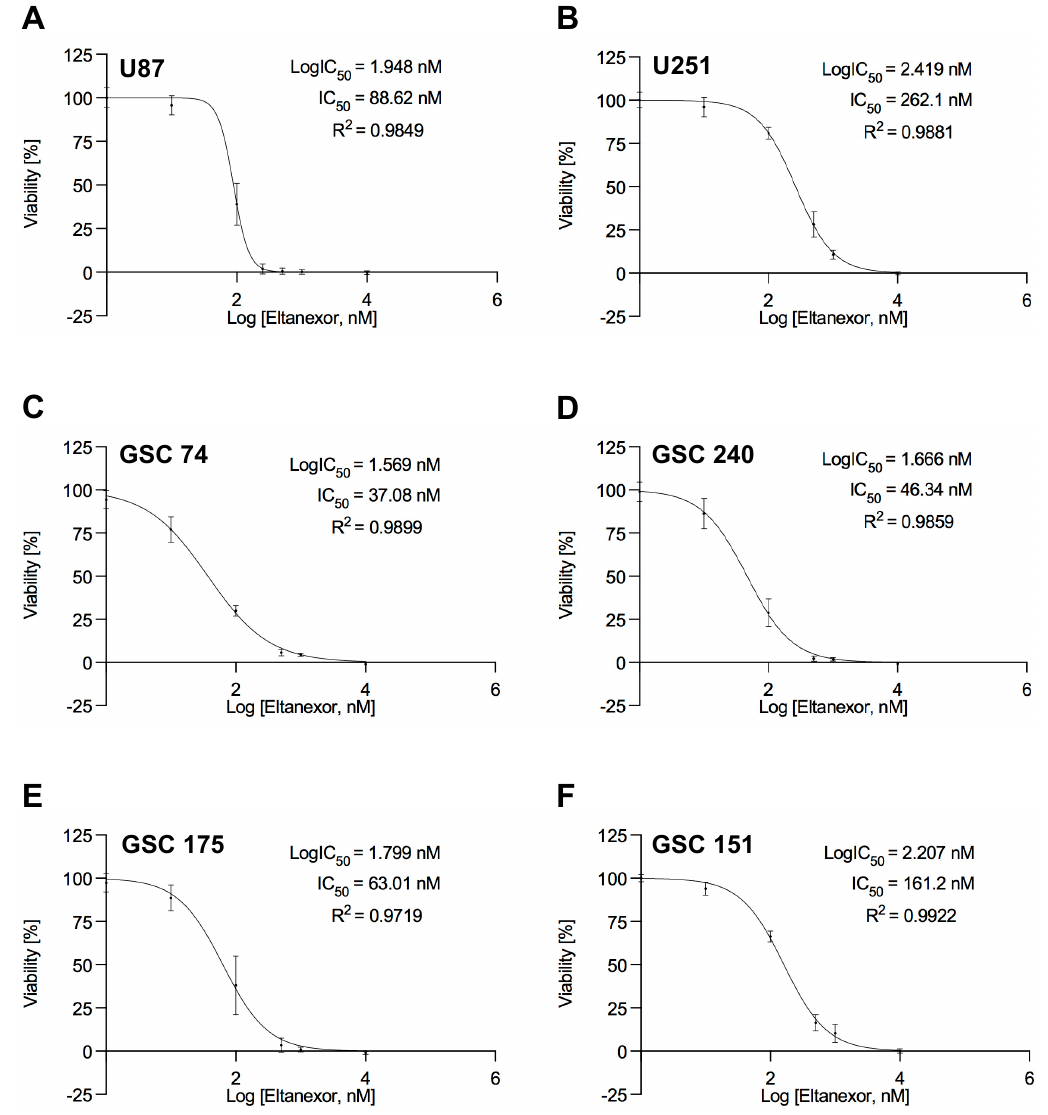
Figure 1. Dose-response curves for Eltanexor for U87 ( A ), U251 ( B ), and four patient-derived GSCs 74 ( C ), 240 ( D ), 175 ( E ), and 151 ( F ). All values are based on triplicate measurements performed in three independent experiments. Cell viability was determined using CellTiter-Glo reagent. IC 50 values were calculated using non-linear regression with the least-square fit. Values (in nM) and the respective regression coefficients are noted in the respective diagrams.